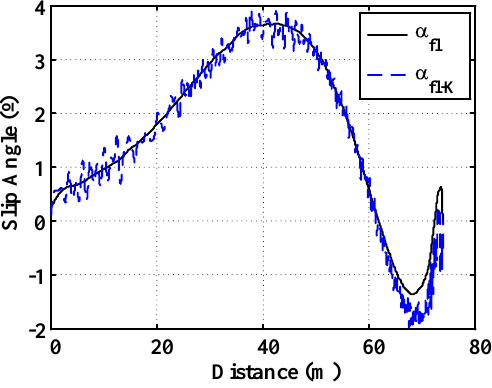
Figure 13. Curve simulation. Surface µ = 0.8. 500 m. radius curve. Slip angle comparison.